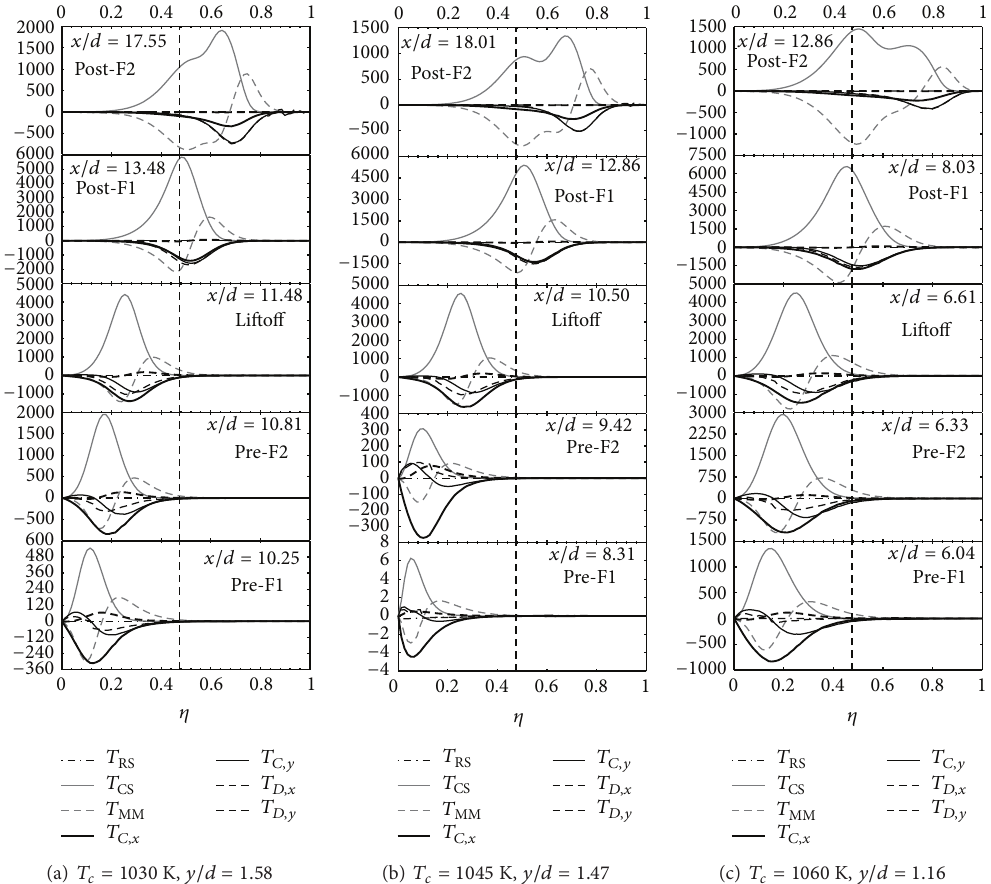
Figure 6: Transport budget of the steady-state 𝑄 𝑇 equation (r.h.s. terms of (9)) at several axial locations around the stabilisation height: (a) = 1030 K ( 𝑦/𝑑 = 1.58 ), (b) 𝑇 = 1045 K ( 𝑦/𝑑 = 1.47 ), and (c) 𝑇 = 1060 K ( 𝑦/𝑑 = 1.16 ). 𝑇 𝑇 , radiative source; 𝑇 , chemical source; 𝑇 , 𝑐 𝑐 𝑐 RS CS MM micromixing; 𝑇 𝐶,𝑥 , axial convection; 𝑇 𝐶,𝑦 , radial convection; 𝑇 𝐷,𝑥 , axial diffusion; 𝑇 𝐷,𝑦 , radial diffusion. The vertical dashed line corresponds to the location of the stoichiometric mixture fraction. All terms are scaled down by a factor of 10 3 and the units are K/s. The CSDR is modelled using Girimaji’s